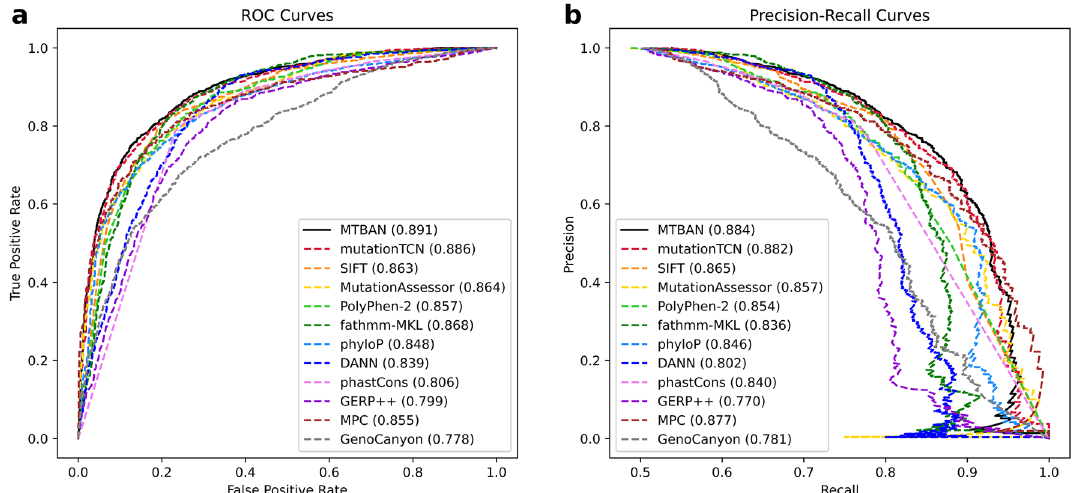
Figure 2. ROC Curves and Precision-Recall Curves for MTBAN and other predictors on the test dataset. ( a ) MTBAN achieved a ROC-AUC (Receiver Operating Characteristic Area Under Curve) of 0.883, which is the